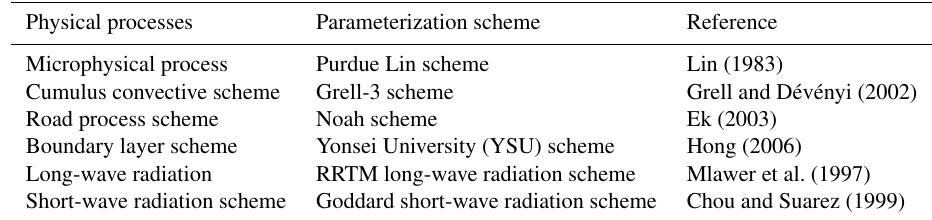
Figure 2. Modeling domain. RRTM is a rapid and accurate radiative transfer model. Table 1. Parameterization scheme of the physical processes in the WRF